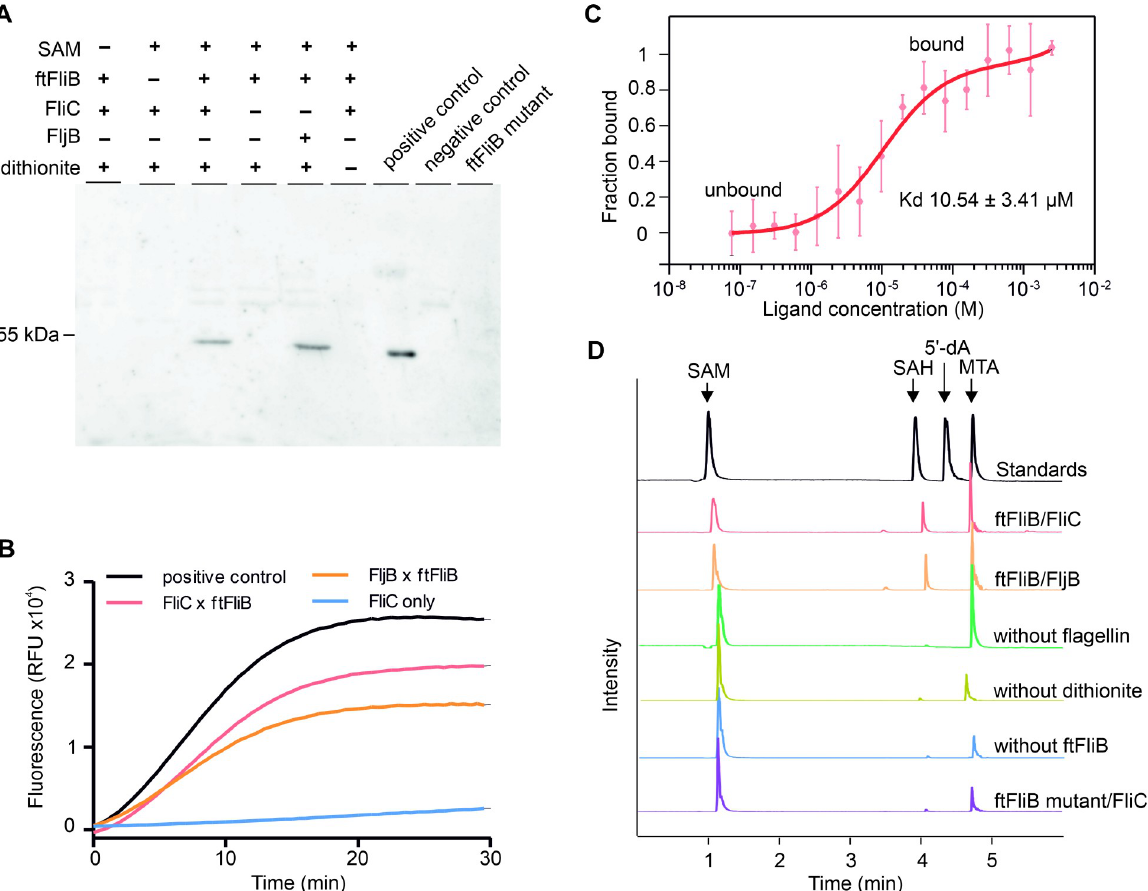
Fig 3. In vitro FliB methylation activity. ( A ) Activity assay using an anti-methylated Lysine antibody. Methylated flagella sheared from wild type S . enterica were used as positive control; unmethylated flagella sheared from S . enterica FliB knockout mutant were used as negative control. Reaction with ftFliB C17A C22A C26A C27A (ftFliB mutant) was conducted in a mixture of SAM, FliC and dithionite. ( B ) Continuous fluorescent methyltransferase assay, SAH was used as a positive control and buffer alone was used as background control. Methylase ftFliB was mixed with either FliC or FljB under reducing environment, and the generation of SAH was measured using enzyme coupled fluorescence assay with an excitation/ emission wavelength of 535/590 nm. ( C ) Ligand binding affinity test of ftFliB and SAM. Binding of methylation ligand SAM to 1 μ M ftFliB was analyzed with label-free MST. Data were shown as mean ± standard deviation (SD) calculated from three independent experiments. ( D ) HPLC-MS analysis of the methylation assay products. The methylation reactions were performed by mixing the methylase (ftFliB) and flagellin under reducing condition: reaction between ftFliB and FliC as ‘ftFliB/FliC’; reaction between ftFliB and FljB as ‘ftFliB/FljB’, control reaction lack of flagellin as ‘without flagellin’, control reaction under non-reducing condition as ‘without dithionite’, control reaction without the methylase as ‘without ftFliB’, reaction of ftFliB mutant with flagellin as ‘ftFliB mutant/FliC’. Extracted ion chromatograms (EIC) of SAM (m/z 399 [M + H] + ), SAH (m/z 385 [M + H] + ), 5’-dA (m/z 252 [M + H] + ), MTA (m/z 298 [M + H] + ) from each reaction were merged in one trace. The chromatograms intensities are normalized to the most abundant EIC.